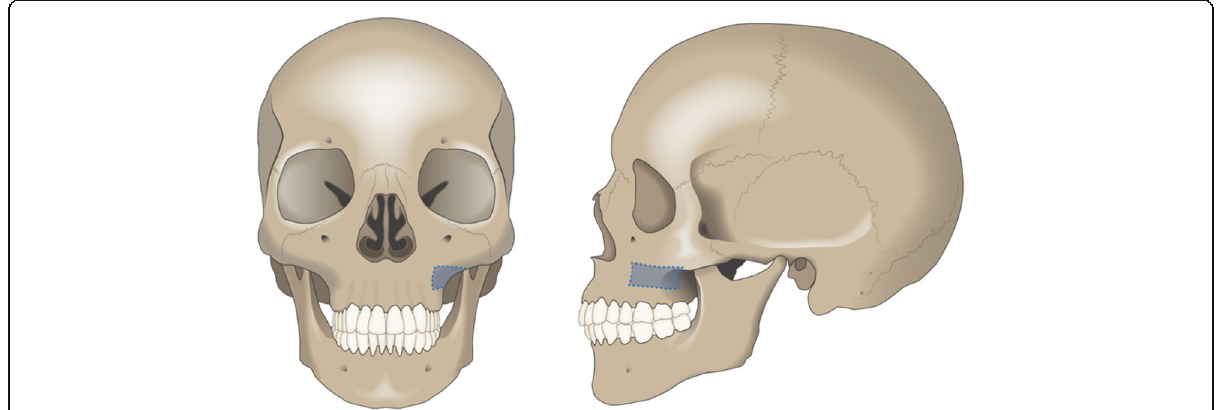
Fig. 1 The frontal and sagittal view of the area of the zygomatic alveolar crest where the bone grafts were taken